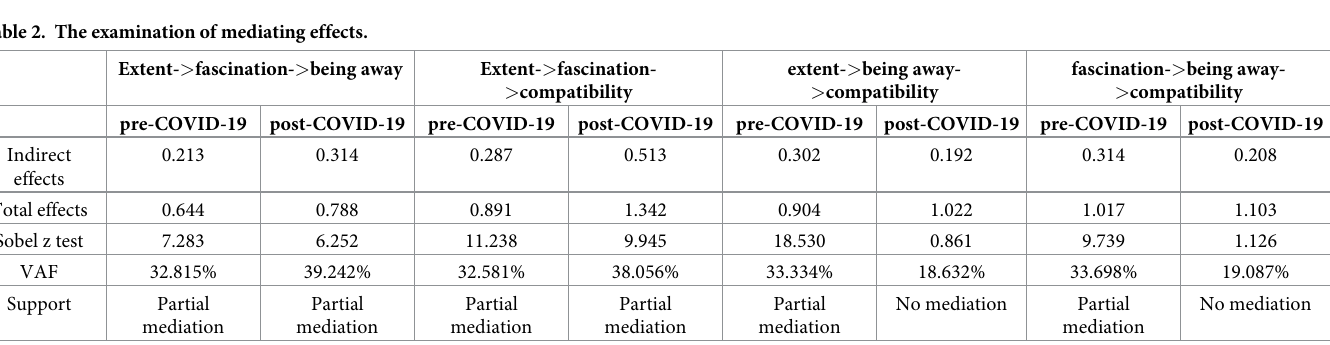
Table 2. The examination of mediating